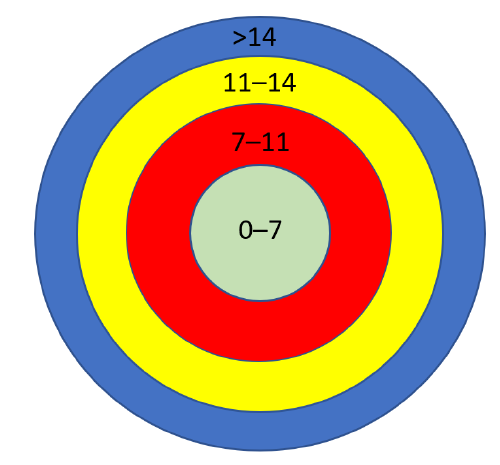
Figure 4. The area divided into